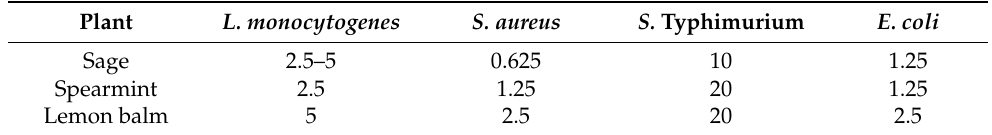
Table 3. Minimal inhibitory concentration (mg/mL) of hydroethanolic solid-liquid extracts ob- tained from spearmint, sage, and lemon balm, against L. monocytogenes , S. aureus , S. enterica ser. Typhimurium, and E. coli . Plant L. monocytogenes S.